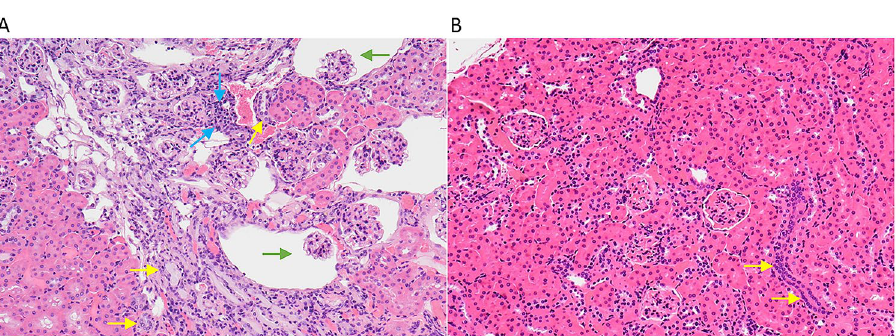
Figure 4. Representative images of H and E-stained kidney sections from mice treated with a drug cocktail or control. (A) The control mouse kidney shows moderate to severe aging lesions (scored as a grade 3). Specific lesions include moderate nephropathy characterized by multifocal tubular basophilia (yellow arrows), glomerular atrophy and dilated Bowman’s space (green arrows) and interstitial inflammatory infiltrates (blue arrows). (B) The cocktail treated mouse kidney shows fewer and less severe aging changes (scored as a grade 1), characterized by focal tubular basophilia (yellow arrows). Magnification